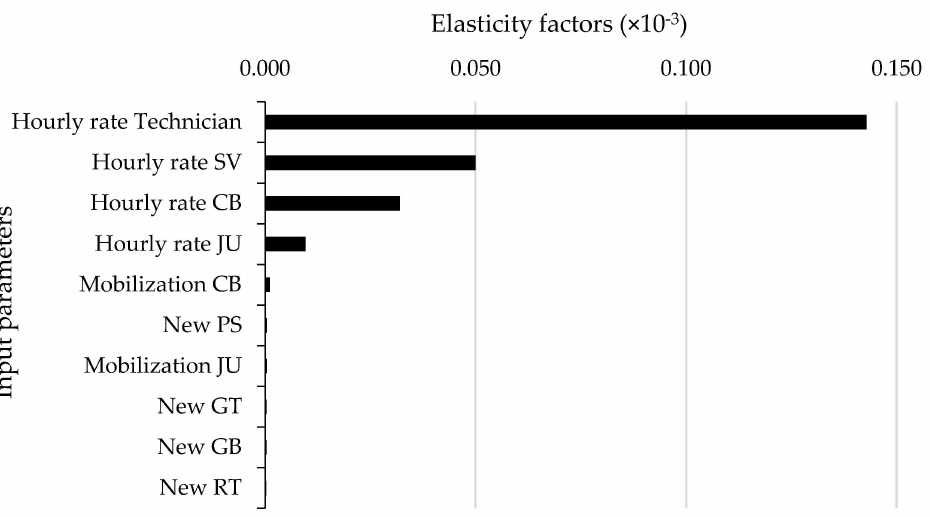
Figure 12. Elasticity factors of input parameters in terms of accounting rate of